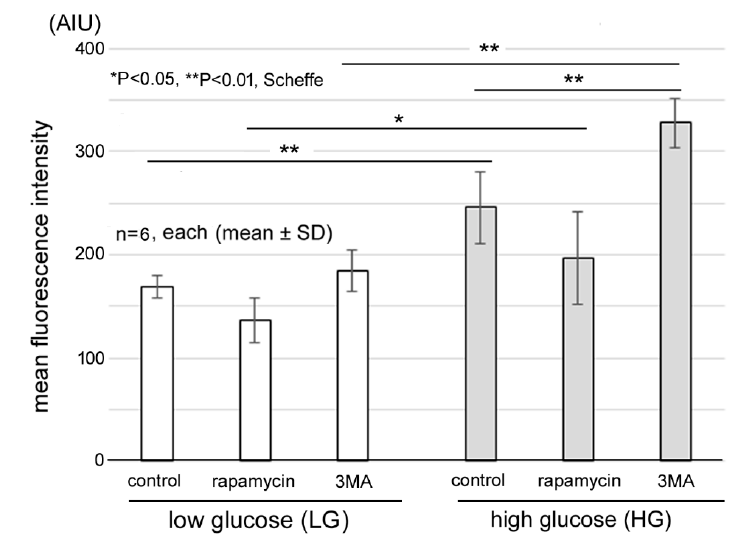
Figure 4. Quantitative analyses of intracellular superoxide levels. The intracellular superoxide levels are shown by fluorescein intensities in arbitrary intensity units (AIUs). Superoxide levels are significantly higher under HG control than LG control. Similarly, superoxide levels are significantly higher between other corresponding groups under HG condition than LG condition. Inhibition of autophagy by 3MA caused a further significant increase under HG condition while it did not increase the level under LG condition. Rapamycin slightly decreased the fluorescein intensities from the control in both conditions, but the e ff ect was not significant. ** p < 0.01, * p < 0.05, Sche ff e; n = 6 each.